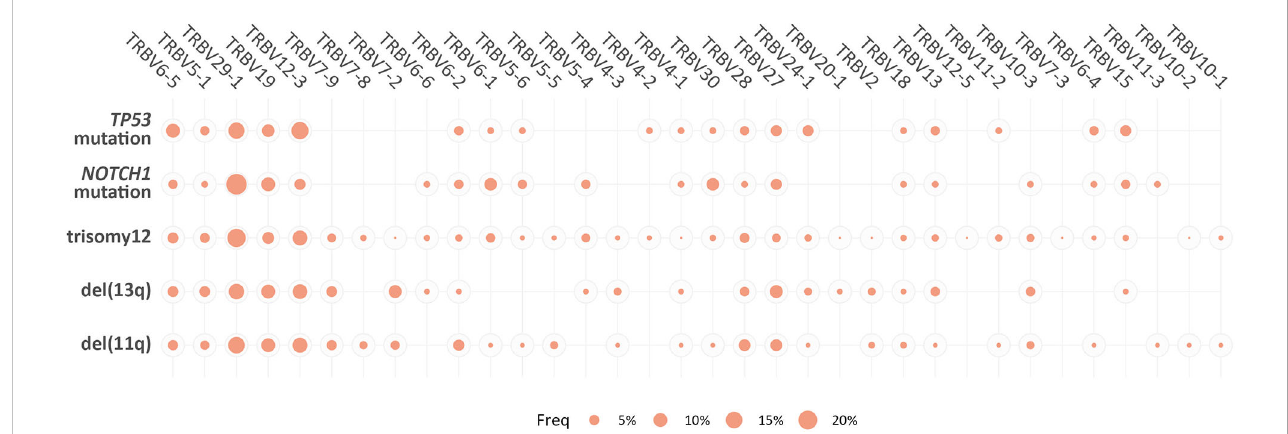
FIGURE 4 Biased TRBV gene usage in the major clonotypes in groups of patients with CLL bearing distinct genomic aberrations. The size of each bubble is proportional to the mean frequency (%) of each TRBV gene in the repertoire of the major clonotypes of all patients within a given